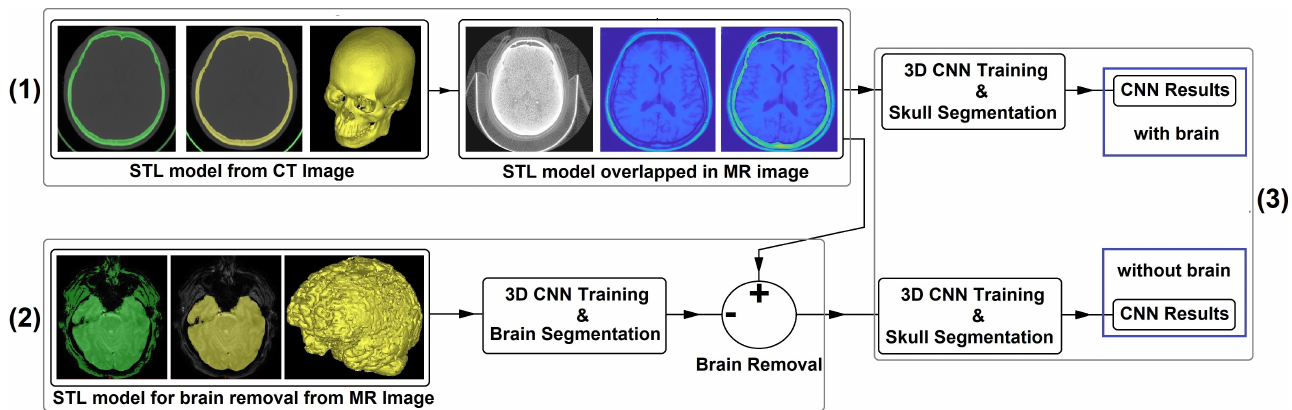
Figure 1. ( 1 ) STL models are produced from 58 CT scans and then overlapped with the MR images to create the first dataset. ( 2 ) 62 MR images are used to create brain STL models, and a brain segmentation algorithm is created. The brain segmentation algorithm is combined with manual corrections to remove the brain from dataset 1 to create dataset 2. ( 3 ) Finally, these 2 datasets are compared using the same CNN